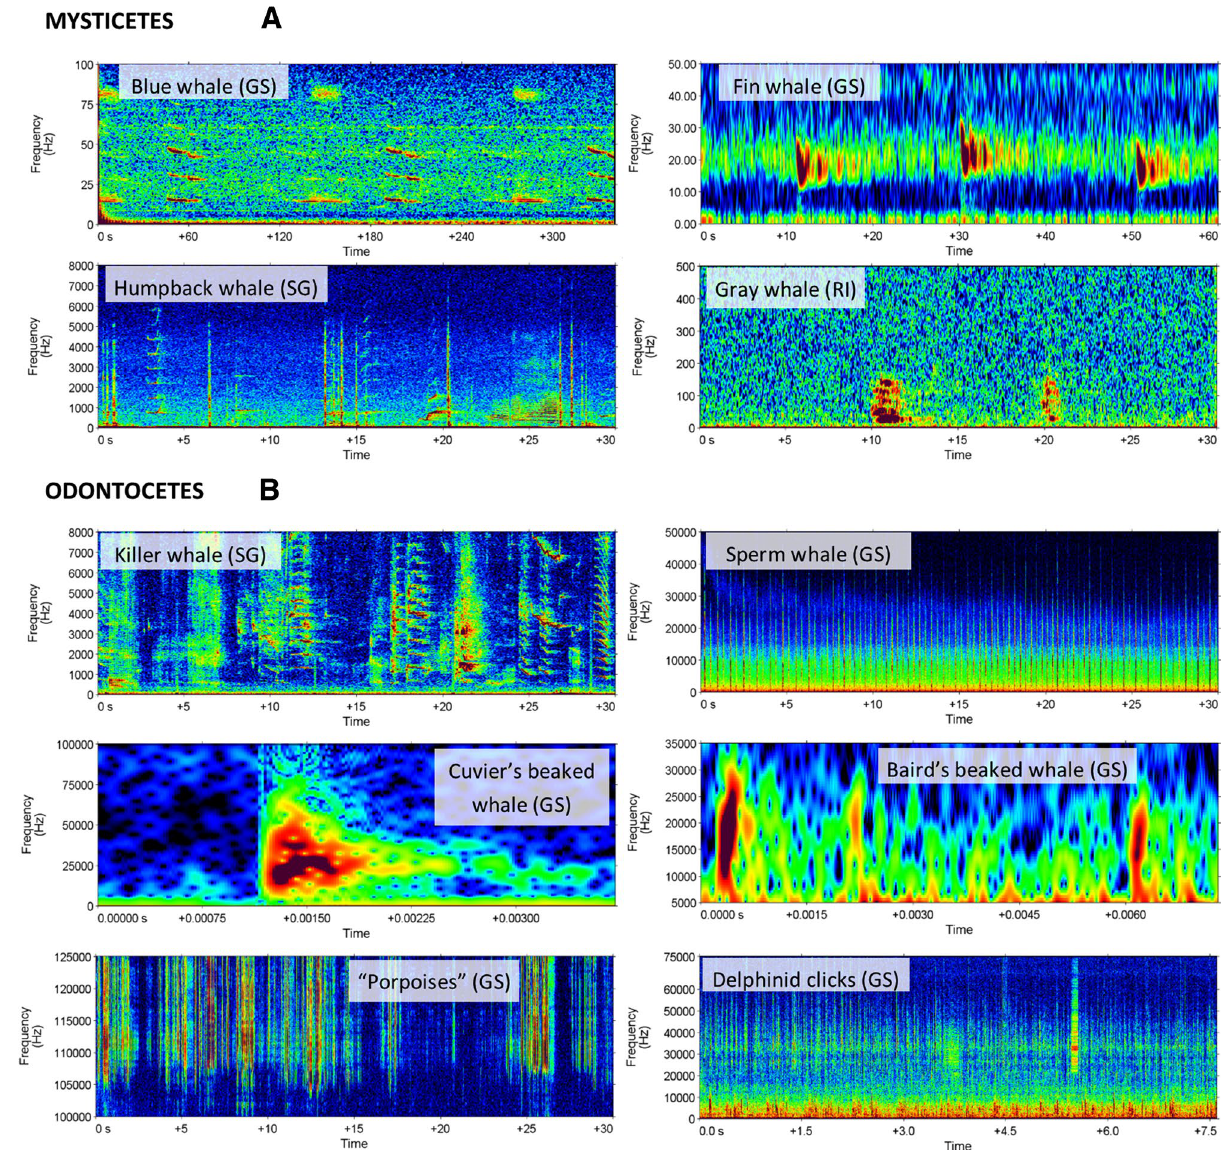
Figure 3. Spectrograms of four mysticetes and six odontocetes calls detected in Gwaii Haanas. For easier viewing, spectrograms (all: Hamming window) are plotted on different time and frequency scales. Blue whale (Gowgaia Slope): infrasonic ( A – B ) vocalizations (0.4 Hz frequency resolution, 2 s time window, 0.5 s time step). Fin whale (Gowgaia Slope): 20-Hz pulses (0.25 Hz frequency resolution, 0.3 s time window, 0.03 s time step). Gray whale (Ramsay Island): vocalizations; Humpback whales (SG ̱ ang Gwaay): song vocalizations; Killer whales (SG ̱ ang Gwaay): vocalizations (all 2 Hz frequency resolution, 0.128 s time window, 0.032 s time step). Sperm whale (Gowgaia Slope): clicks (64 Hz frequency resolution, 0.01 s time window, 0.005 s time step). Cuvier’s and Baird’s beaked whales (Gowgaia Slope): clicks (512 Hz frequency resolution, 0.26 ms time window, 0.02 ms time step). Porpoises and Dolphin (unidentified delphinid click trains) (Gowgaia Slope): clicks (64 Hz frequency resolution, 0.01 s time window, 0.005 s time manual analysis of the recordings at all locations, although undetected right whale tonals could have been missed during bouts with humpback songs. Similarly, no minke whale ( Balaenoptera acutorostrata ) vocalizations were found during the systematic manual analysis of recordings at any location. No sei whale ( Balaenoptera borealis ) vocalizations could be identified with confidence. For odontocetes, killer whale vocalizations (not identified to the ecotypes) were sparsely detected via auto- mated and manual analysis at all three locations. Sperm whale clicks were common in GS data and detected at SG, but not RI. Cuvier’s beaked whale ( Ziphius cavirostris ) clicks were identified in the GS high-frequency recordings, as were infrequent clicks produced by Baird’s beaked whale ( Berardius bairdii ). High-frequency clicks were identified throughout GS high-frequency recordings and identified as “porpoises”. We are currently unable to confidently differentiate between Dall’s porpoise ( Phocoenoides dalli ), harbour porpoise ( Phocoena